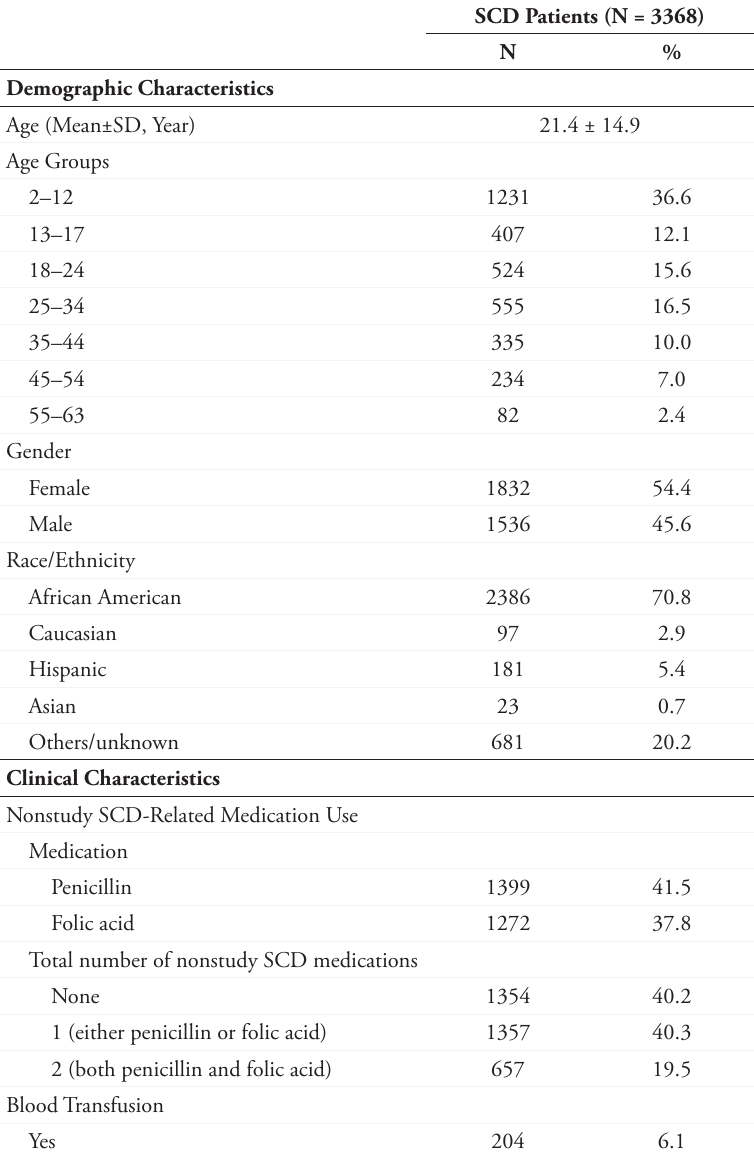
Table 1. Baseline Characteristics for Patients with SCD (N =